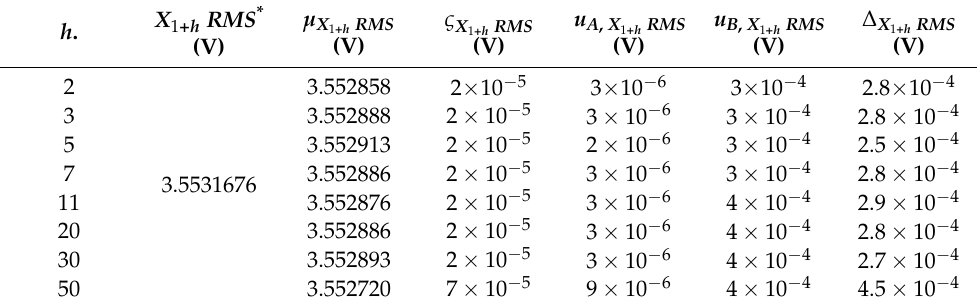
Table 7. Steady-state standard harmonic disturbance signal characterization results. h .